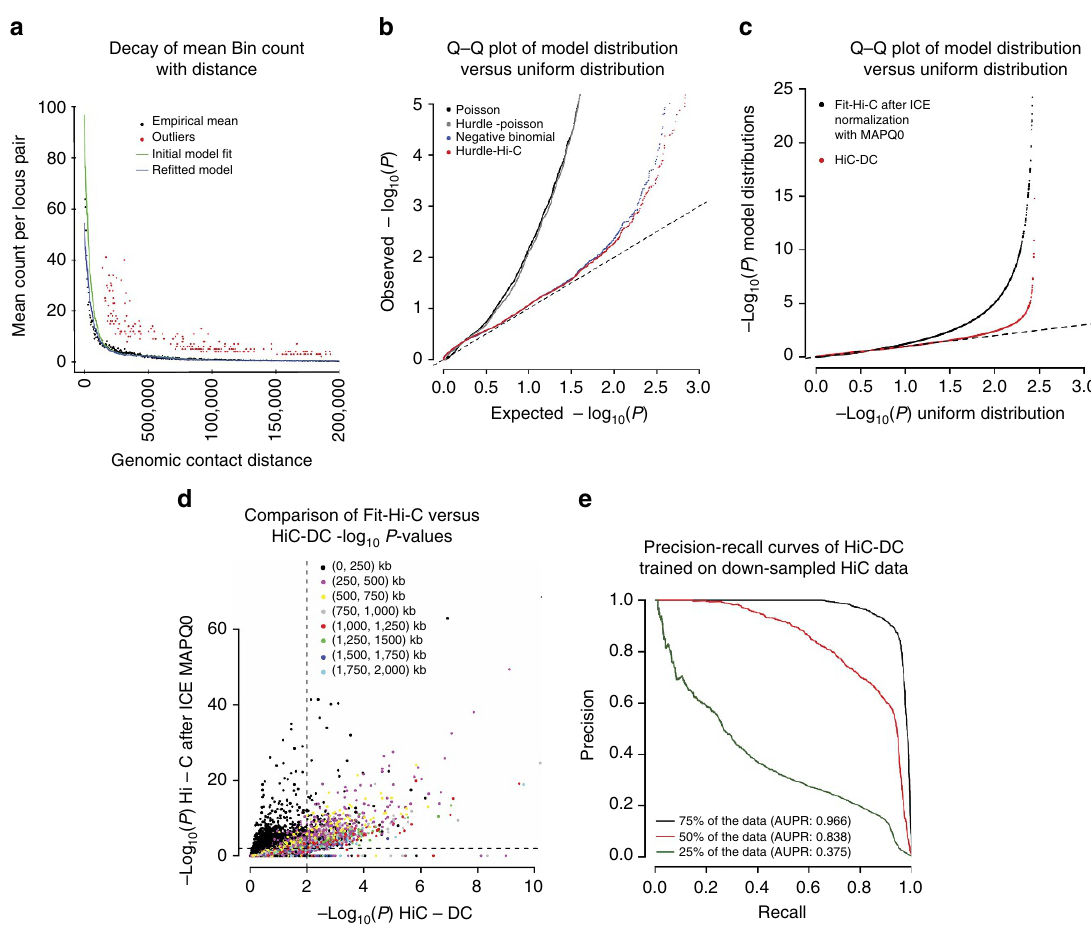
Figure 1 | HiC-DC reduces inflation in estimates of statistical significance of Hi-C interactions. ( a ) Expected interaction bin counts as a function of genomic distance according to the HiC-DC model for chromosome 1, using the Rao et al. 11 GM12878 Hi-C data set. (Green line) Initial model estimate, prior to outlier removal, plotting the mean of the hurdle regression model as a function of genomic distance and setting other covariates to their mean values. (Red points) Bin counts of outliers with mean counts in the top 3% of the zero-truncated negative binomial regression distribution as estimated by the model for the corresponding bins. (Blue line) Refit model, after removal of outliers. (Black points) Empirical mean bin counts for bins in genomic distance intervals. ( b ) Q–Q plots P values estimated by HiC-DC (zero-truncated negative binomial regression) as well as zero-truncated Poisson, negative binomial, and Poisson models ( y axis) versus uniform distribution ( x axis). All models were estimated on chromosome 1 of the Rao et al. 11 GM12878 data set. ( c ) Q–Q plots for HiC-DC and Fit-Hi-C, a method that uses ICE normalization to account for biases and estimates a binomial distribution using a spline fit. ( d ) Scatterplot of HiC-DC and Fit-Hi-C –log P values on chromosome 1 of the Rao et al. 11 data set for different genomic distance ranges. ( e ) Precision-recall curves for the detection of chromatin interactions by HiC-DC, defined as the interactions significant at FDR o 1% based on all read data, for different downsamplings of reads on chromosome 1 of the Rao et al. 11 GM12878 data